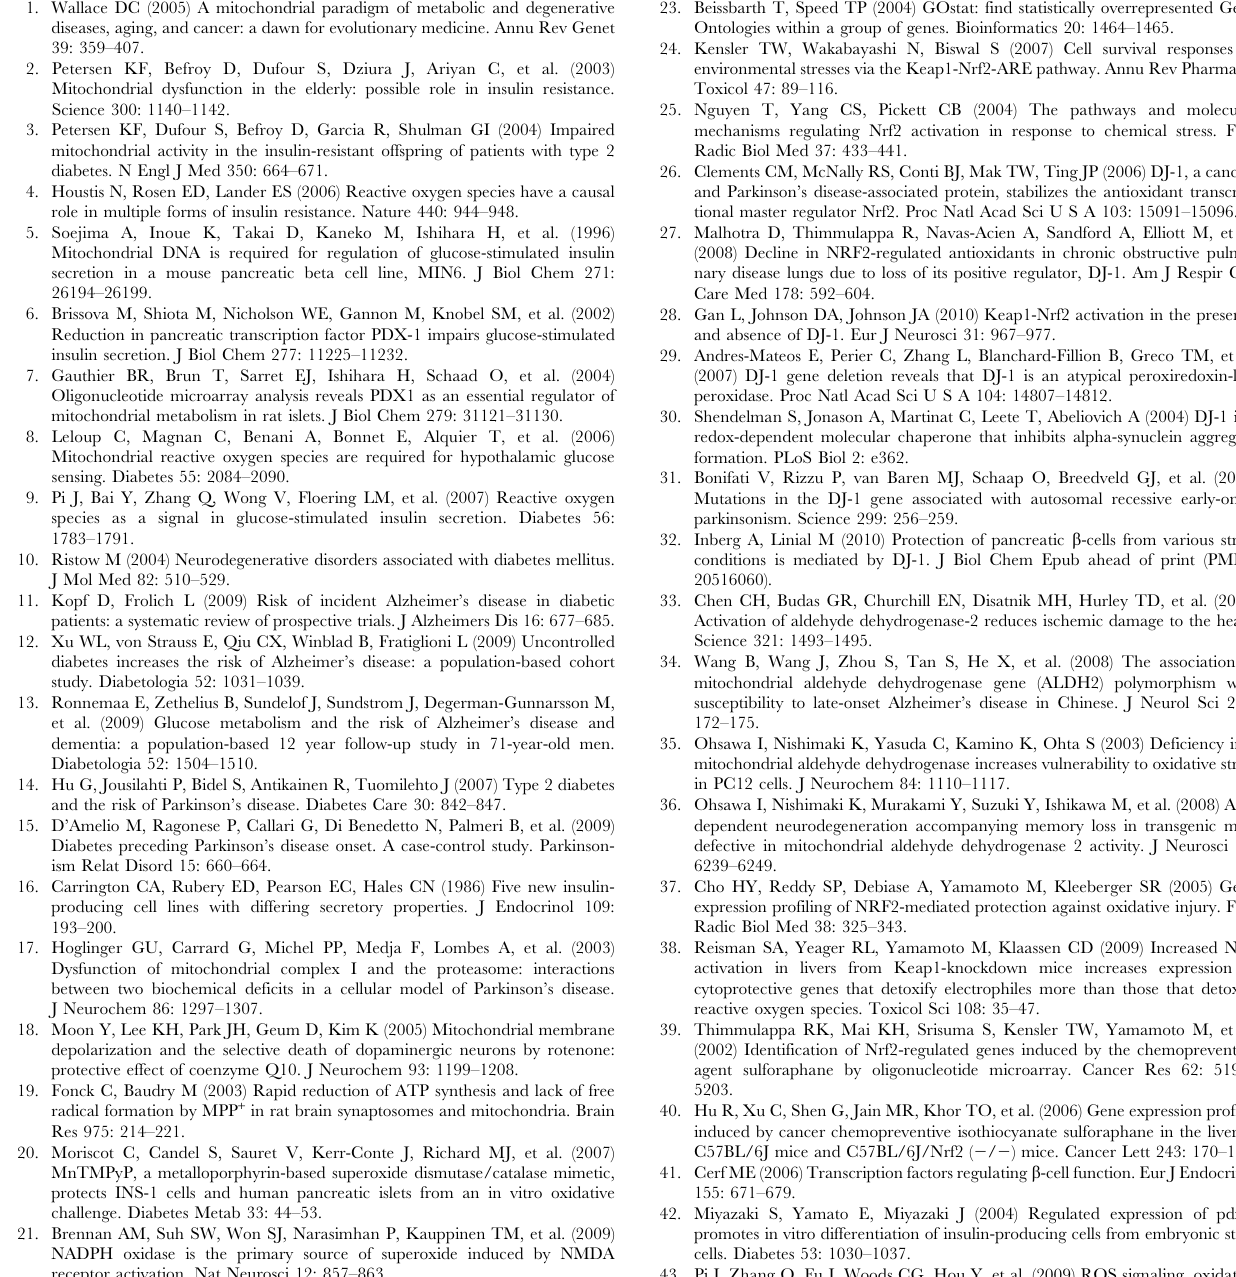
Found at: doi:10.1371/journal.pone.0014485.s012 (0.03 MB